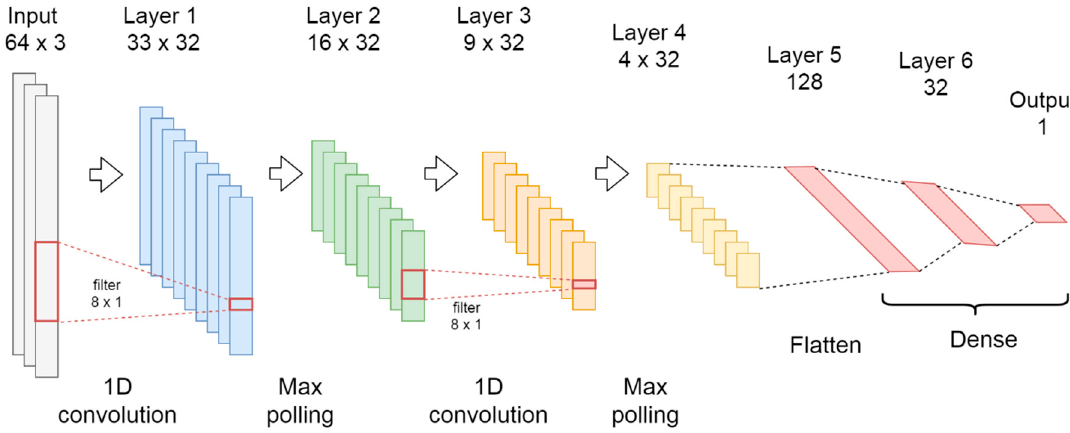
Figure 3. Deep neural network with convolutional layers (CNN).